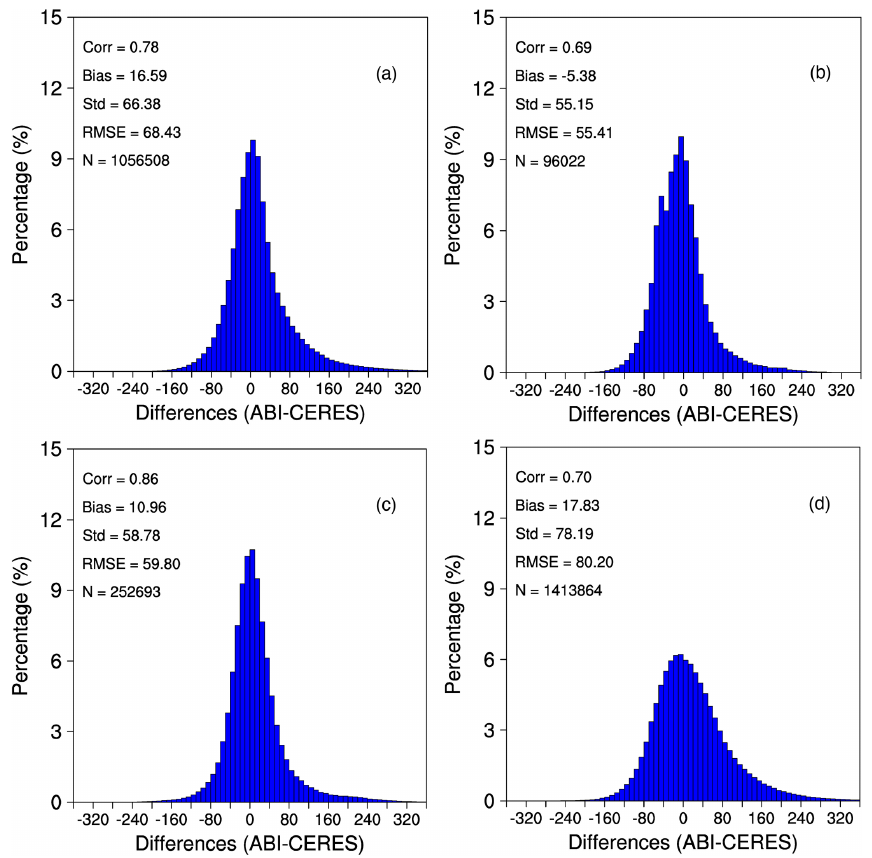
Figure 14. Same as Fig. 11 but for cloudy TOA SW differences.